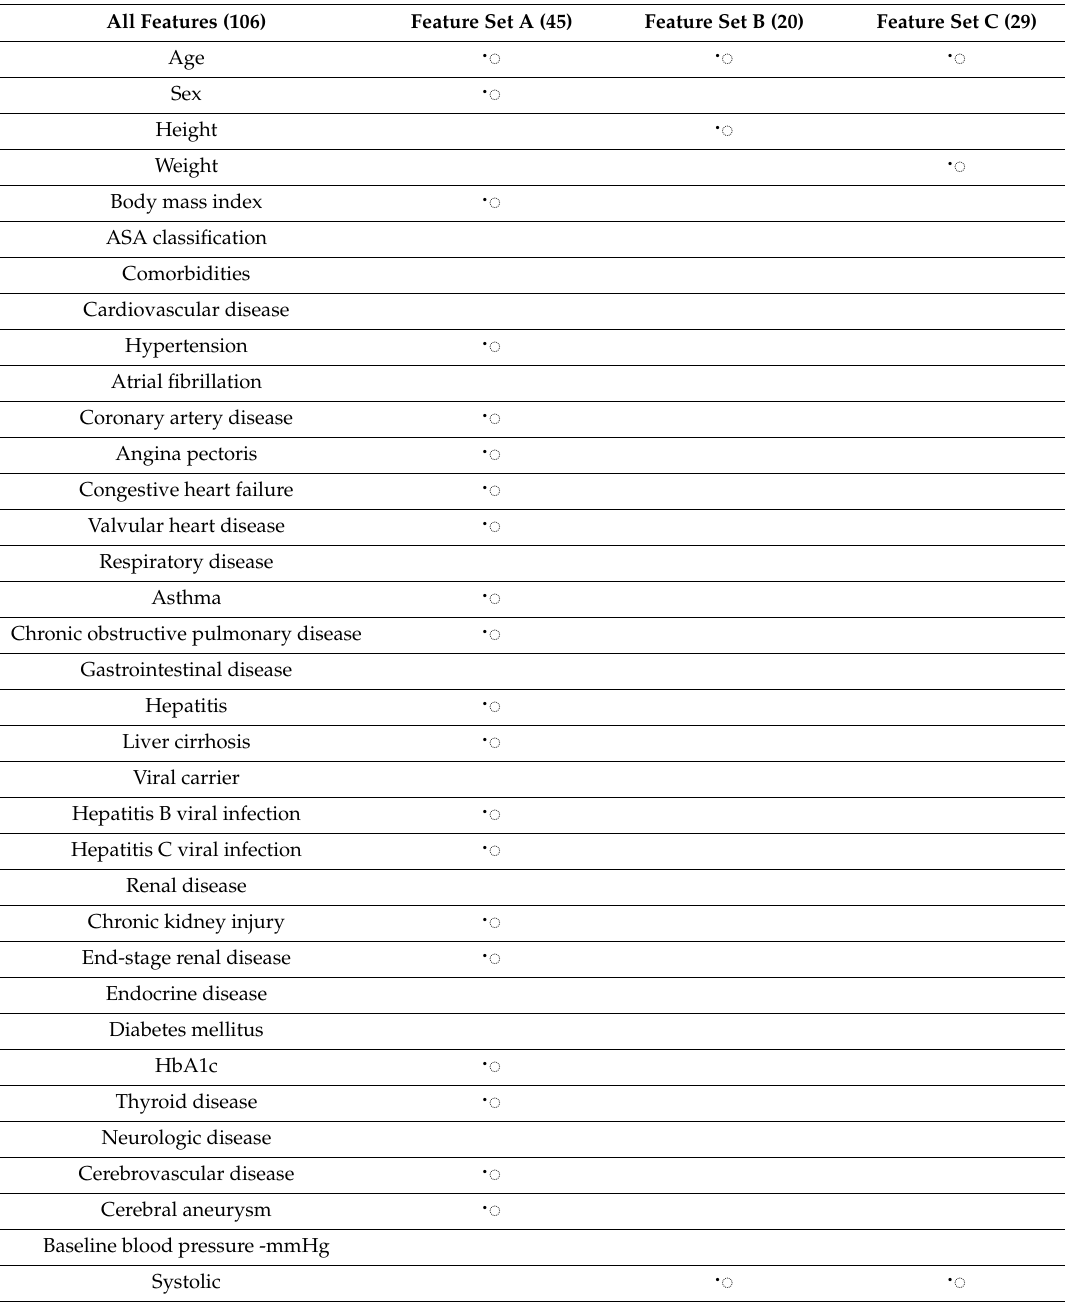
Table A1. Feature sets from feature selection. All features (106)